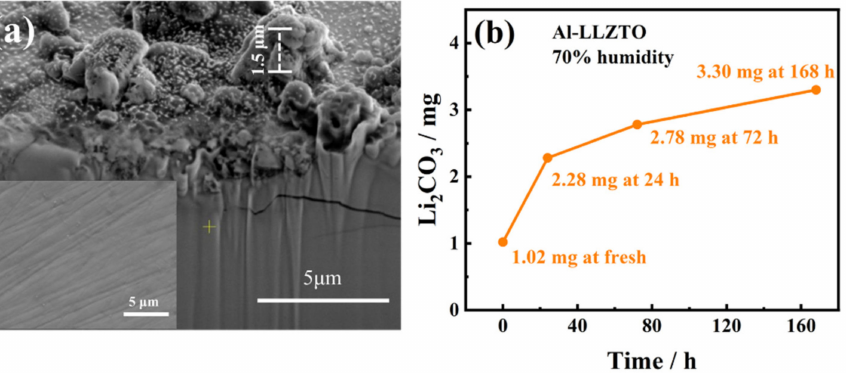
Figure 2. ( a ) The cross-sectional SEM image in combination with FIB for Al-LLZTO. The inset is the polished pristine SEM image of Al-LLZTO. ( b ) Quantitative analysis of Li 2 CO 3 based on TGC technique for micro-sized Al-LLZTO.